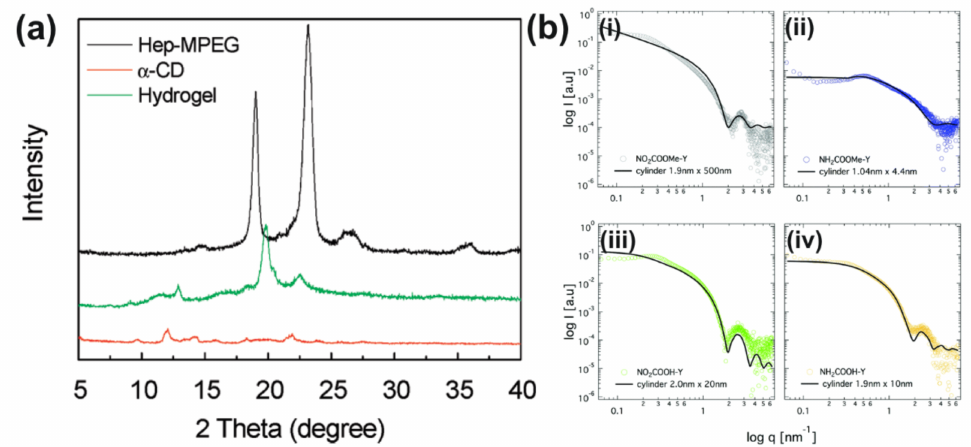
Figure 4. ( a ) X-ray diffraction (XRD) patterns of heparin-conjugated polyethylene glycol methyl ether (Hep-MPEG), α -cyclodextrin ( α -CD), and a freeze-dried hydrogel composed of Hep-MPEG and α -CD. ( b ) Small-angle X-ray scattering (SAXS) data with curves fit to a cylindrical model for hydrogels made in 0.01 M NaCl from 3 wt% gelator: (i) NO 2 COOMe-Y, (ii) NH 2 COOMe-Y, (iii) NO 2 COOH-Y, and (iv) NH 2 COOH-Y. Reproduced with permission ( a ) from [48] ©2010, American Society of Chemistry; ( b ) from [17] ©2019, Royal Society of